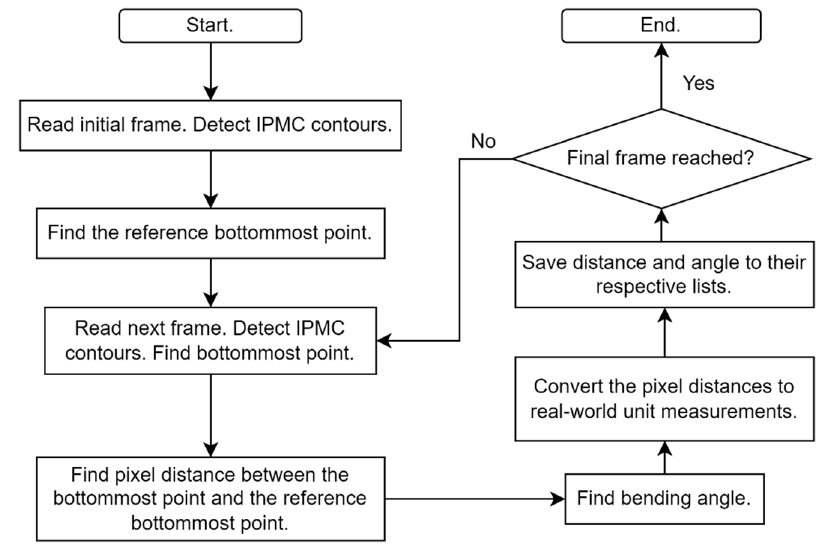
Figure 3. Flow chart of the proposed progression of the vision system.